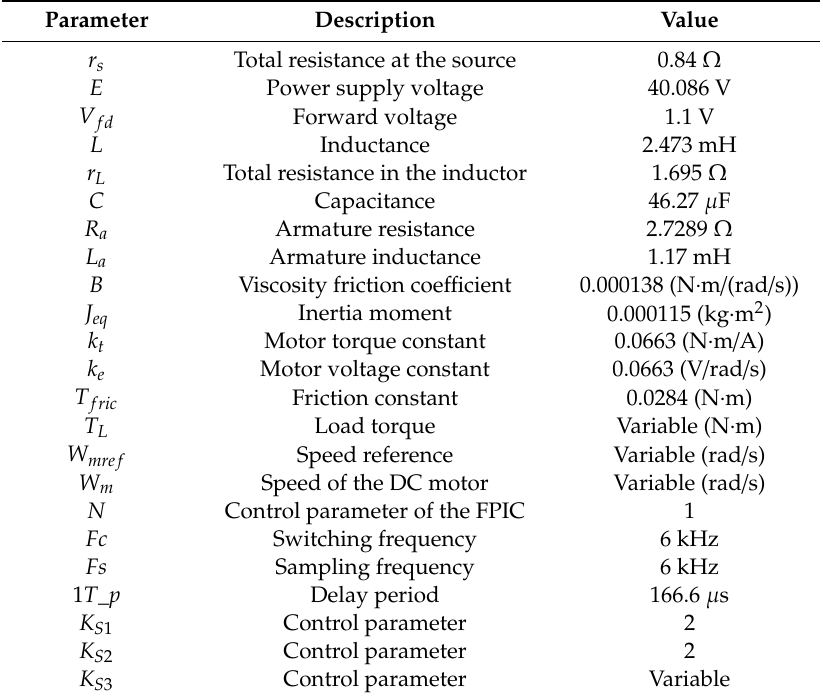
Table 1. Parameters of the controller and the